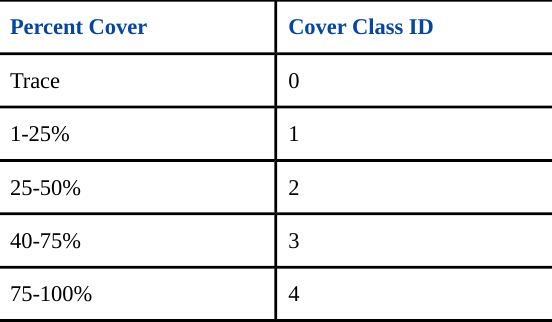
Table 1. Percent cover classes for preliminary data on